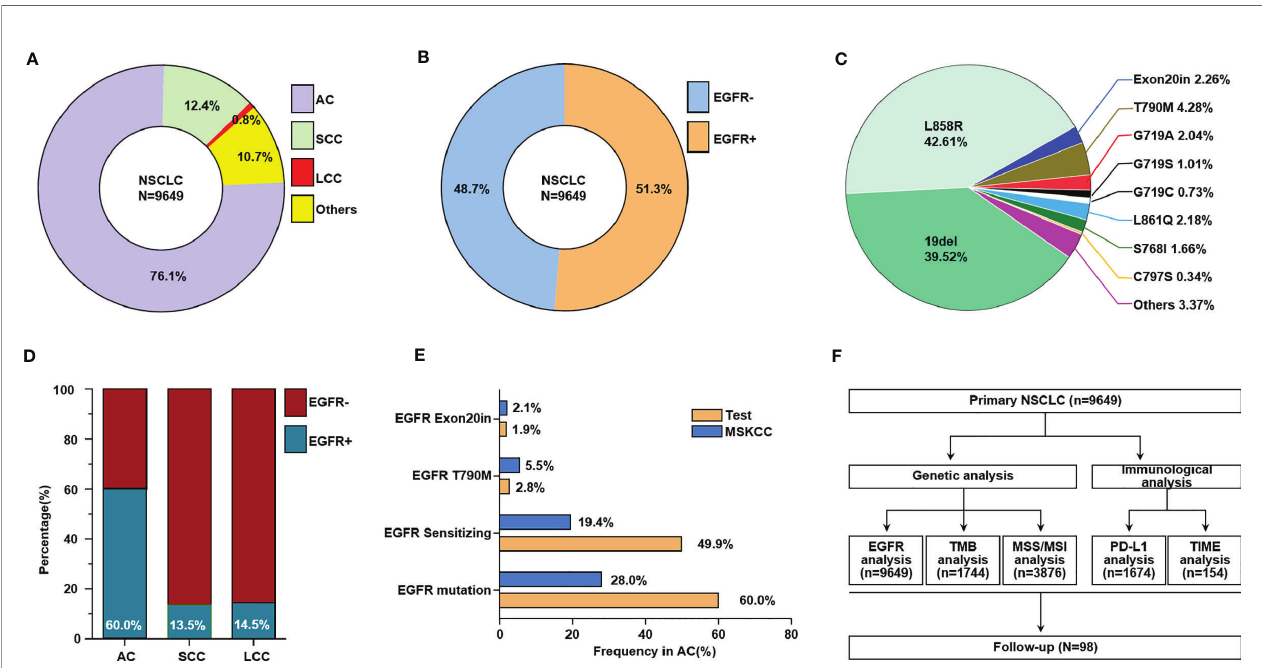
FIGURE 1 | The frequencies of different subtypes of EGFR mutations in Chinese primary NSCLC. (A) The proportion of different histologic types of NSCLC, others including adenosquamous carcinoma, sarcomatoid carcinoma, typical carcinoid, atypical carcinoid, lyphoepithelionma-like carcinoma, etc. (B) The ratio of NSCLC patients with EGFR mutation and without EGFR mutation. (C) The ratio of different EGFR mutation subtypes in NSCLC patients. (D) The ratio of patients with EGFR mutation and without EGFR mutation in different histologic types of NSCLC. (E) Comparison of selected gene alteration frequencies in this research and MSKCC cohort. (F) Flow charts for data analysis in this research. AC, adenocarcinoma; SCC, squamous cell carcinoma; LCC, large cell